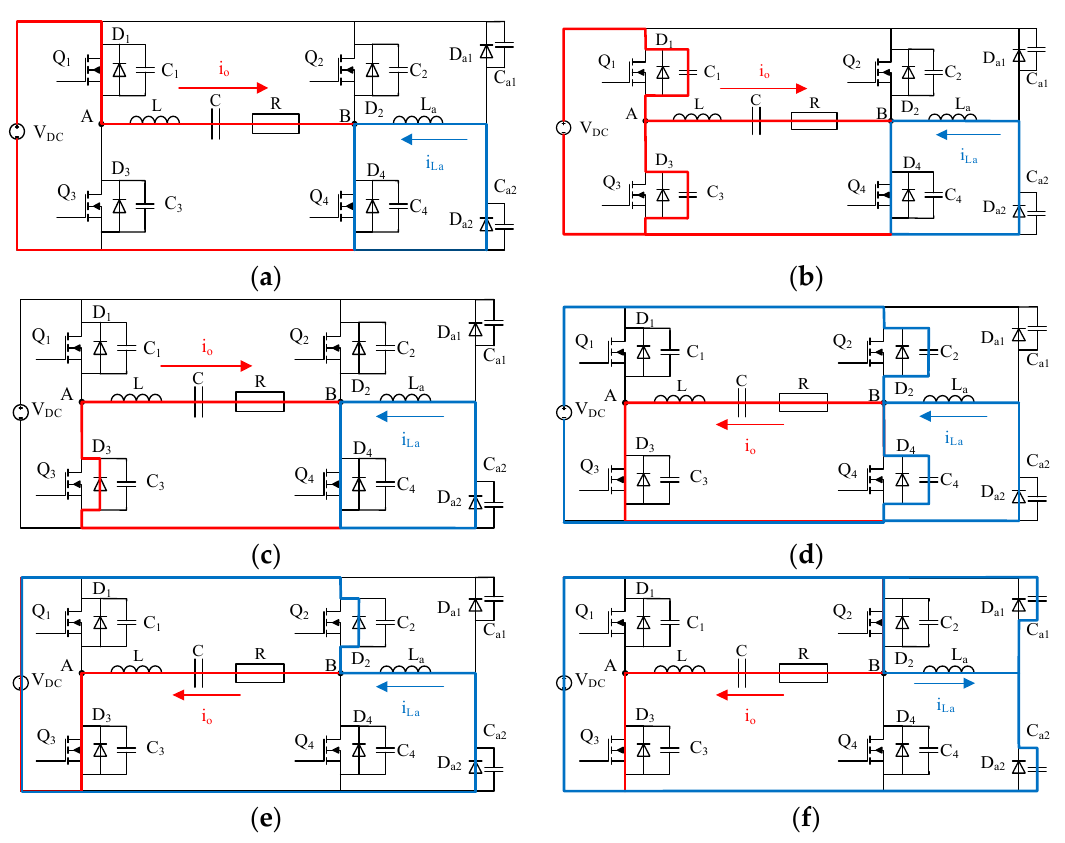
Figure 4. Current path diagrams for various switching modes. ( a – f ) Switching mode 1–6.